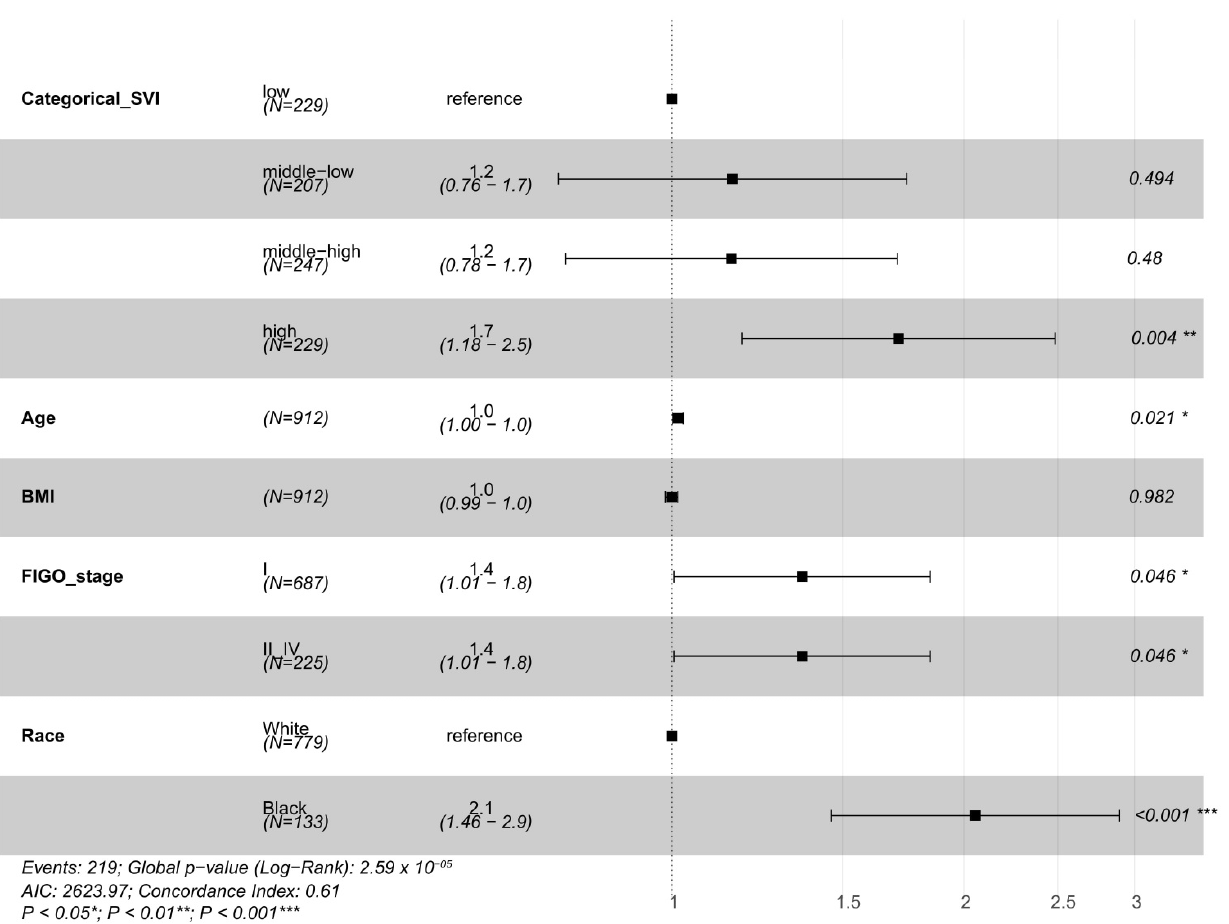
Figure 2. Overall deaths survival analysis hazard ratios. In the overall deaths survival analysis, SVI high is significant ( p = 0.008) when adjusting for age, BMI, FIGO stage, and race. Advanced age, higher BMI, and Black women have odds ratios greater than or equal to 1 and therefore are at an increased risk of death. Table 3. Overall Deaths Multivariable Analysis with Categorical Variables.